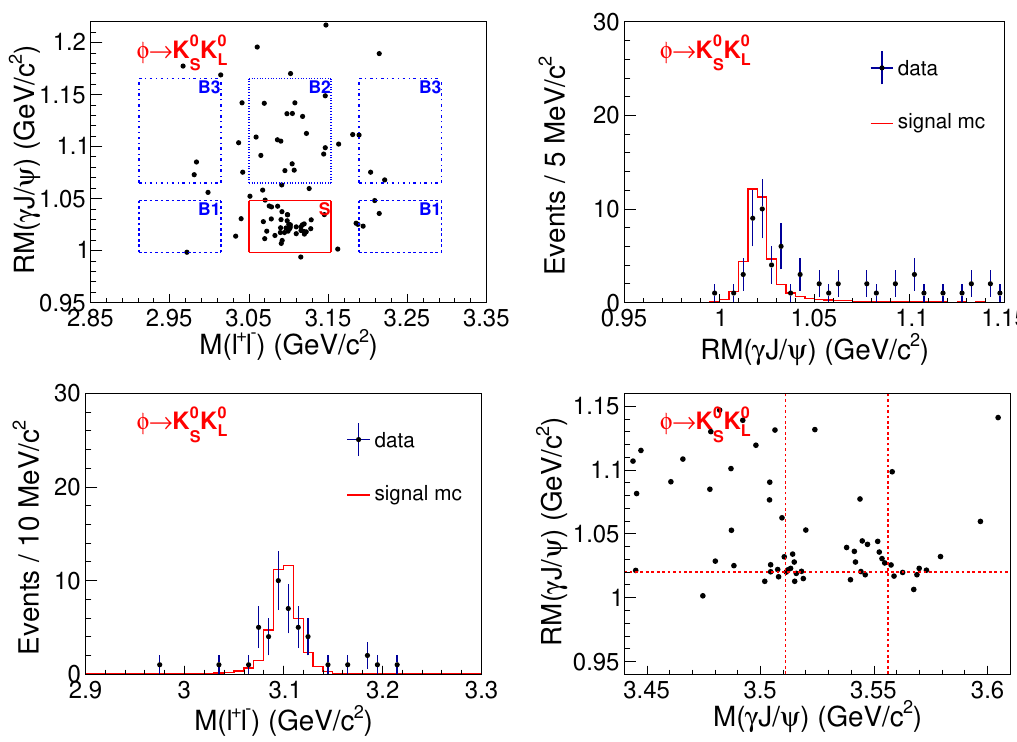
Figure 3 . The 2-dimensional distribution of the RM ( γJ/ψ ) versus M ( ‘ + ‘ − ) (upper left), the invariant mass distributions of the RM ( γJ/ψ ) (upper right), M ( ‘ + ‘ − ) (bottom left) and the 2- dimensional distribution of the RM ( γJ/ψ ) versus M ( γJ/ψ ) (bottom right) in the φ → K 0 mode. Dots with and without error bars are the full data, the red histograms are the signal MC. In the upper left panel, the red solid box is the φJ/ψ signal region (S), the blue dashed, dotted and dash-dotted boxes indicate the φ non- J/ψ (B1), J/ψ non- φ (B2) and non- φ non- J/ψ (B3) sideband regions, respectively. The vertical (horizontal) dashed lines in the bottom right panel are central masses of χ c 1 /χ c 2 ( φ